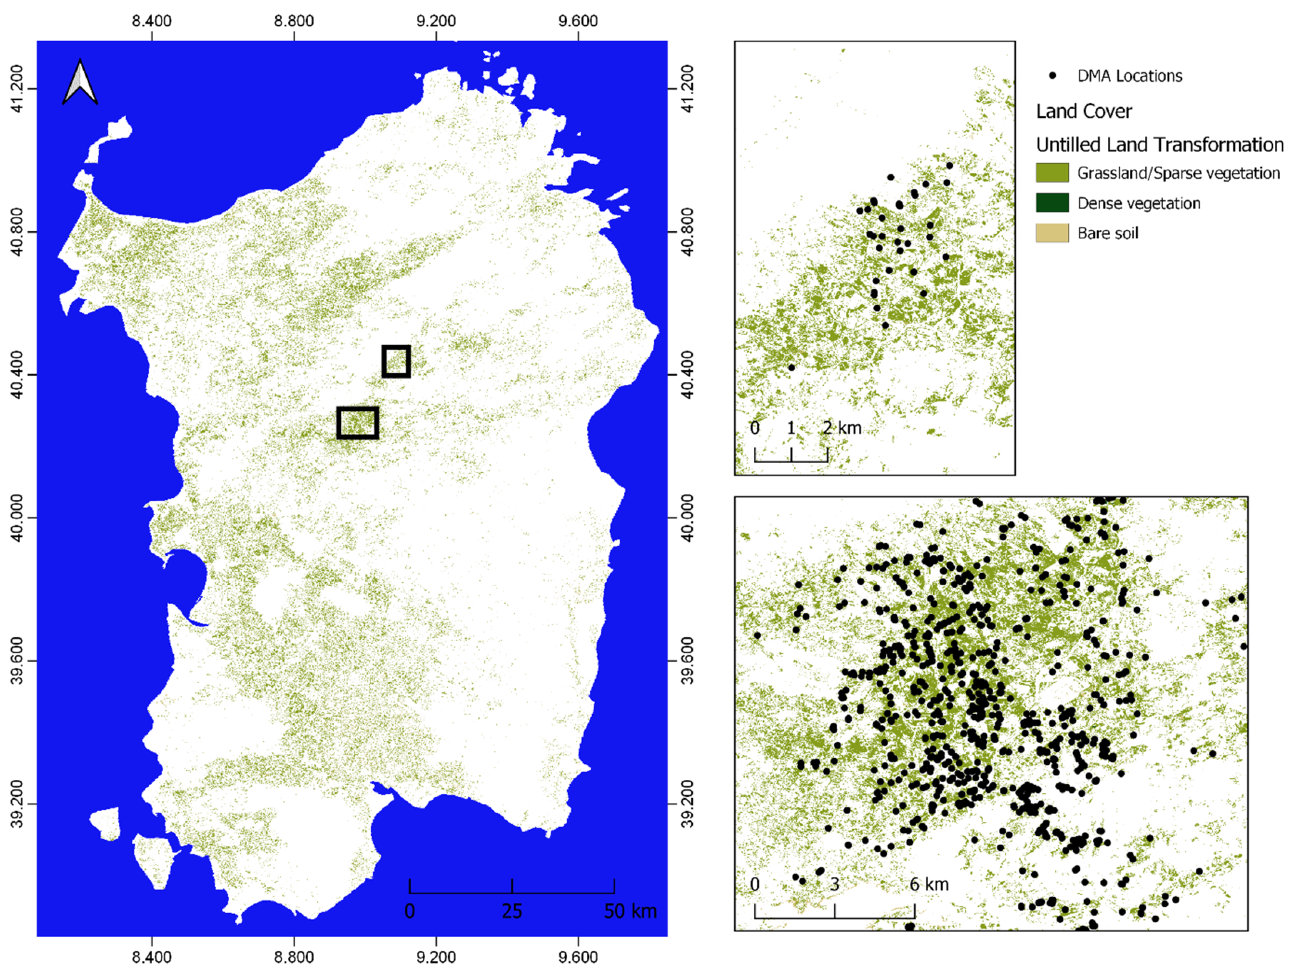
Figure 6. Abandoned land transformation and state in 2021. Zoom areas for region of interest with majority of detected DMA locations.